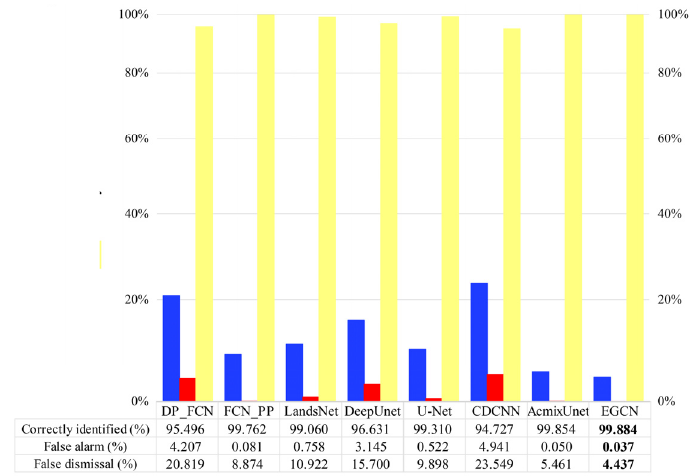
Figure 7. Comparison of the identification results of 8 methods in Region A. Bold values mean the highest number of the corresponding evaluation criterion.